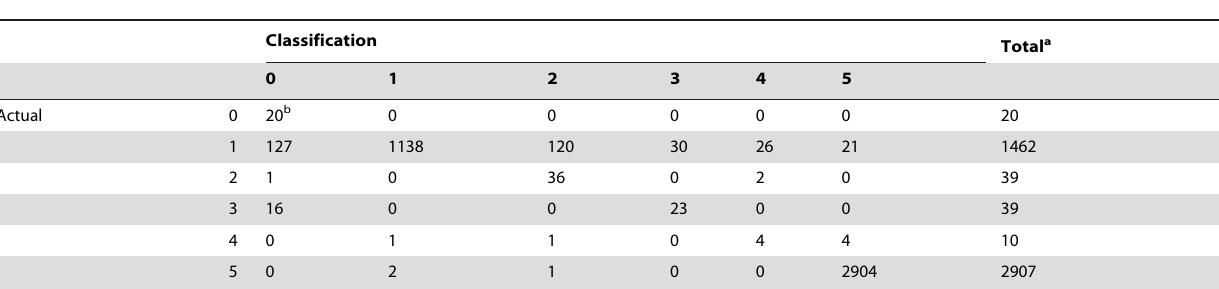
Table 4. Simulation result: One-Step